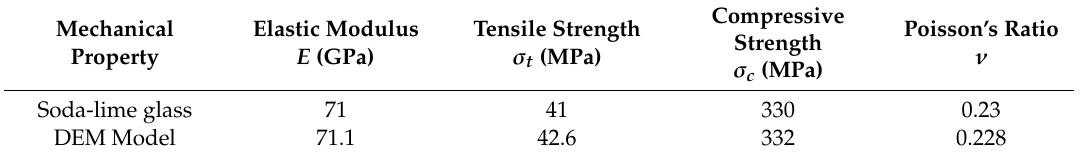
Table 2. Comparison of properties between the discrete element method (DEM) model and soda- lime